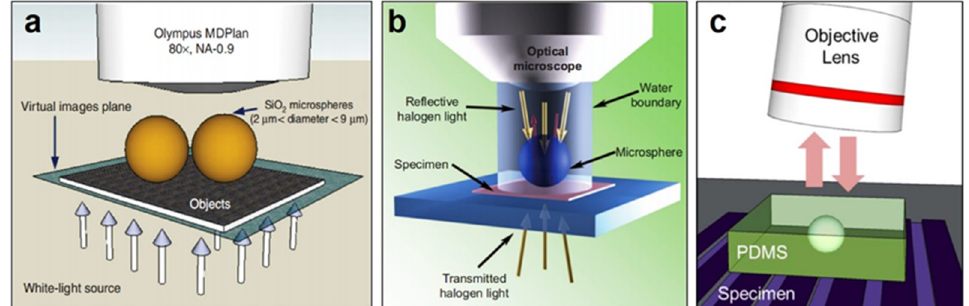
Figure 1. Schematic diagram of different microsphere superlens experimental setups. Schematic diagrams of the device with microspheres in an ( a ) air medium, ( b ) liquid medium, and ( c ) solid medium.